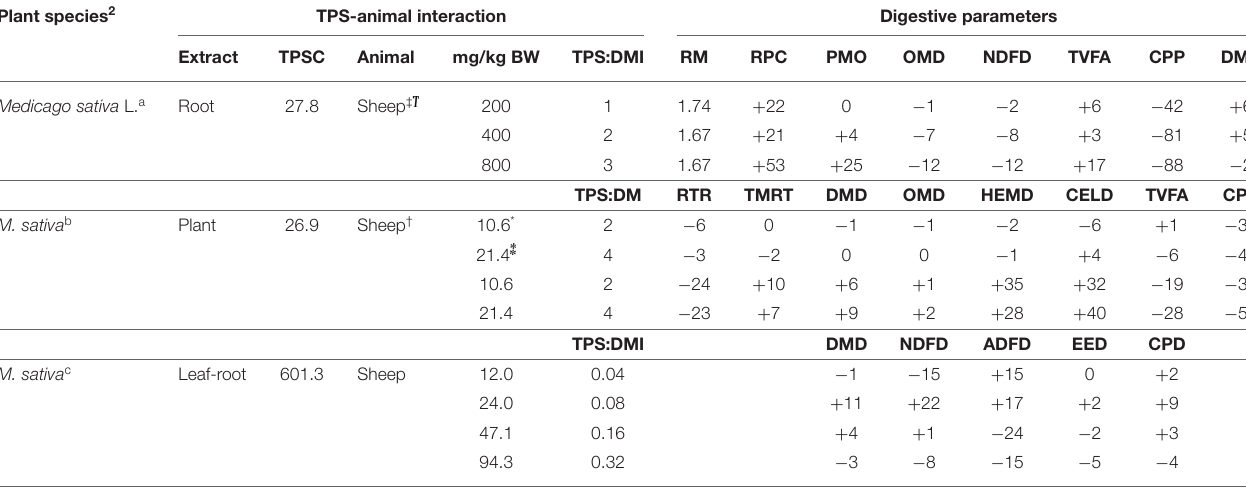
TABLE 1 | Effects of triterpenoid saponin (TPS) supplementation on several ruminal and total gastrointestinal tract parameters 1 . Plant species 2 TPS-animal interaction Digestive parameters